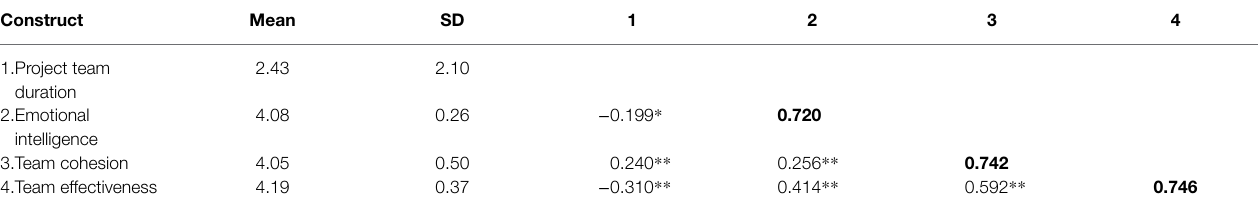
TABLE 3 | Descriptive statistics and correlation matrix. Construct